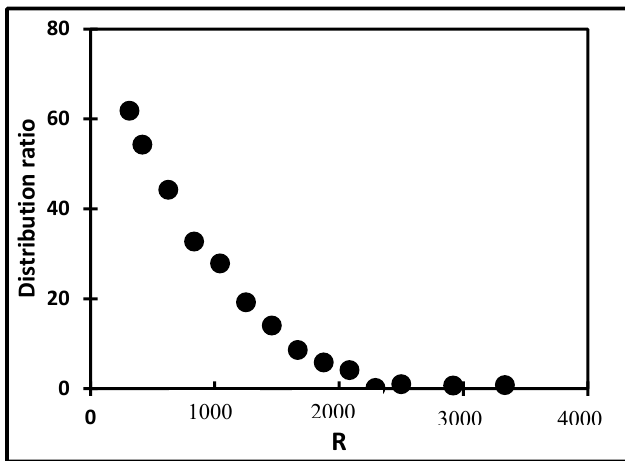
Figure 5. Influence of R on Rh extraction by P 66614 Cl (duplicates, A/O = 3, 24 h, room temperature, (Rh) = 2.4 × 10 − 3 M). Table 2. Influence of HCl concentration on Rh extraction efficiency. Corresponding R values in parenthesis. HCl Concentration (M)